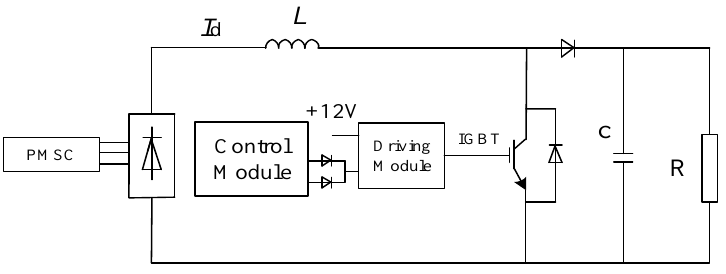
Figure 3. Boost speed control circuit of IGBT.